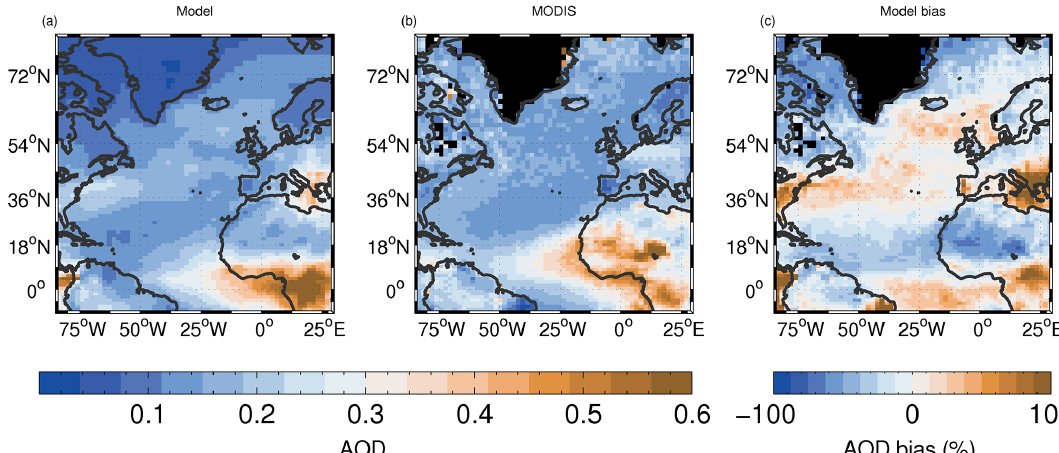
Figure C1. Time-mean 550nm aerosol optical depth (AOD) model evaluation. The MODIS data are from daytime overpasses of the Aqua satellite using the combined Dark Target and Deep Blue level-3 product. Model local times within 3h on either side of 13:30LT are used to approximately match the satellite overpass